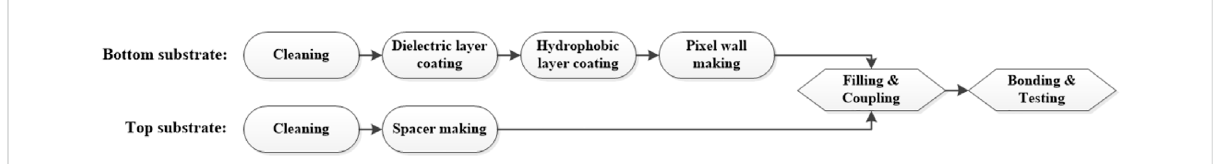
FIGURE 4 Fabrication process of an EWD device.